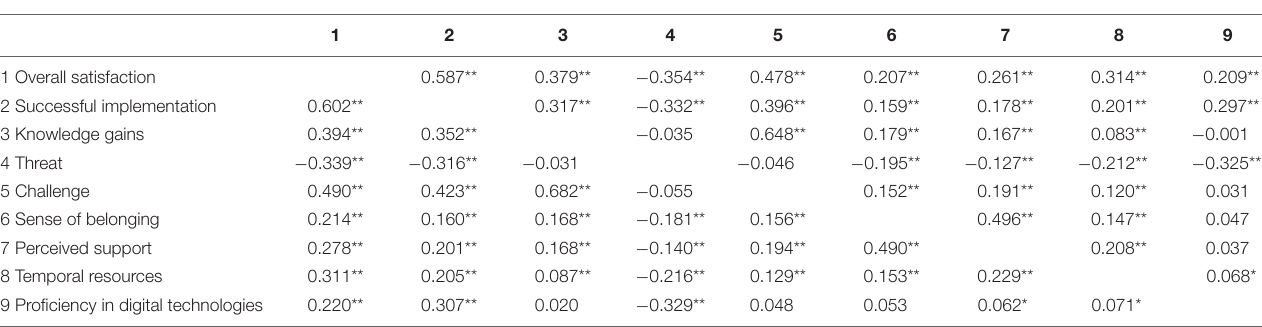
TABLE 2 | Correlations between variables (Spearman-Rho above, Pearson below primary